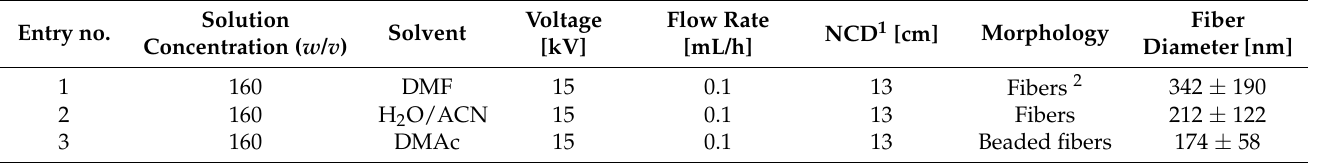
Table 2. Electrospinning parameters—solvent